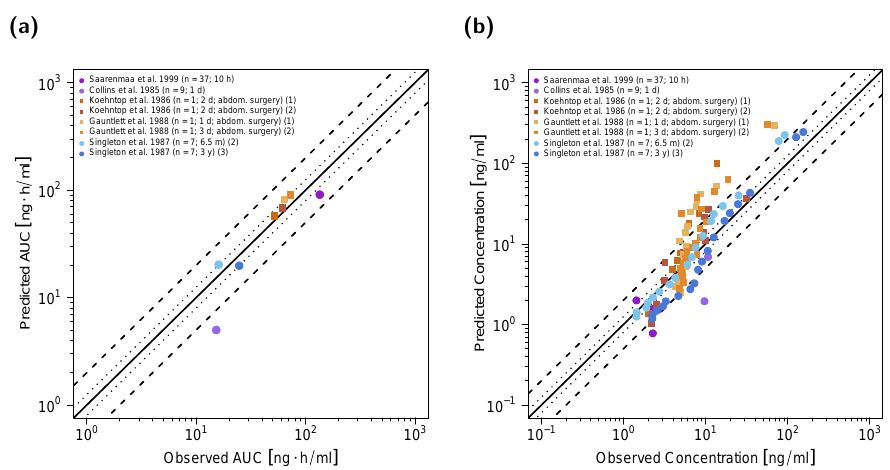
Figure 6. Predicted versus observed AUC last ( a ) and plasma concentrations ( b ) of fentanyl for the pediatric PBPK model. Squares depict values for individual patients with adjusted clearances due to increased intraabdominal pressure as explained in Section 3.4; circles depict values for study populations without adjustment of clearances. In ( a ), each symbol represents the AUC last of a single plasma concentration–time profile. In ( b ), each symbol represents a single plasma concentration. The black solid lines mark the lines of identity. Black dotted lines indicate 1.25-fold deviation; black dashed lines indicate 2-fold deviation. AUC last : area under the plasma concentration–time curve from the first to the last data point; abdom.: abdominal.